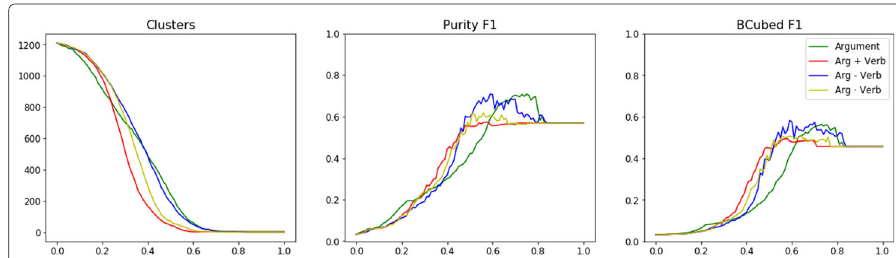
Fig. 7 Semantic role induction results achieved using information regarding the verb. The horizontal axes refer to the neighboring threshold used to create the edges